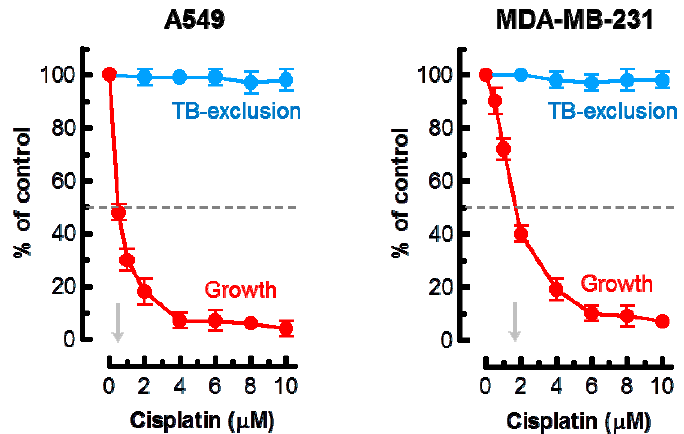
Figure 1. Effect of cisplatin treatment (3 days) on the extent of cell growth and viability of the indicated cell lines, determined by direct cell counting and the trypan blue-exclusion assay, respectively. Arrows show cisplatin concentrations resulting in 50% inhibition of growth. Bars, standard error (SE). TB, trypan blue.